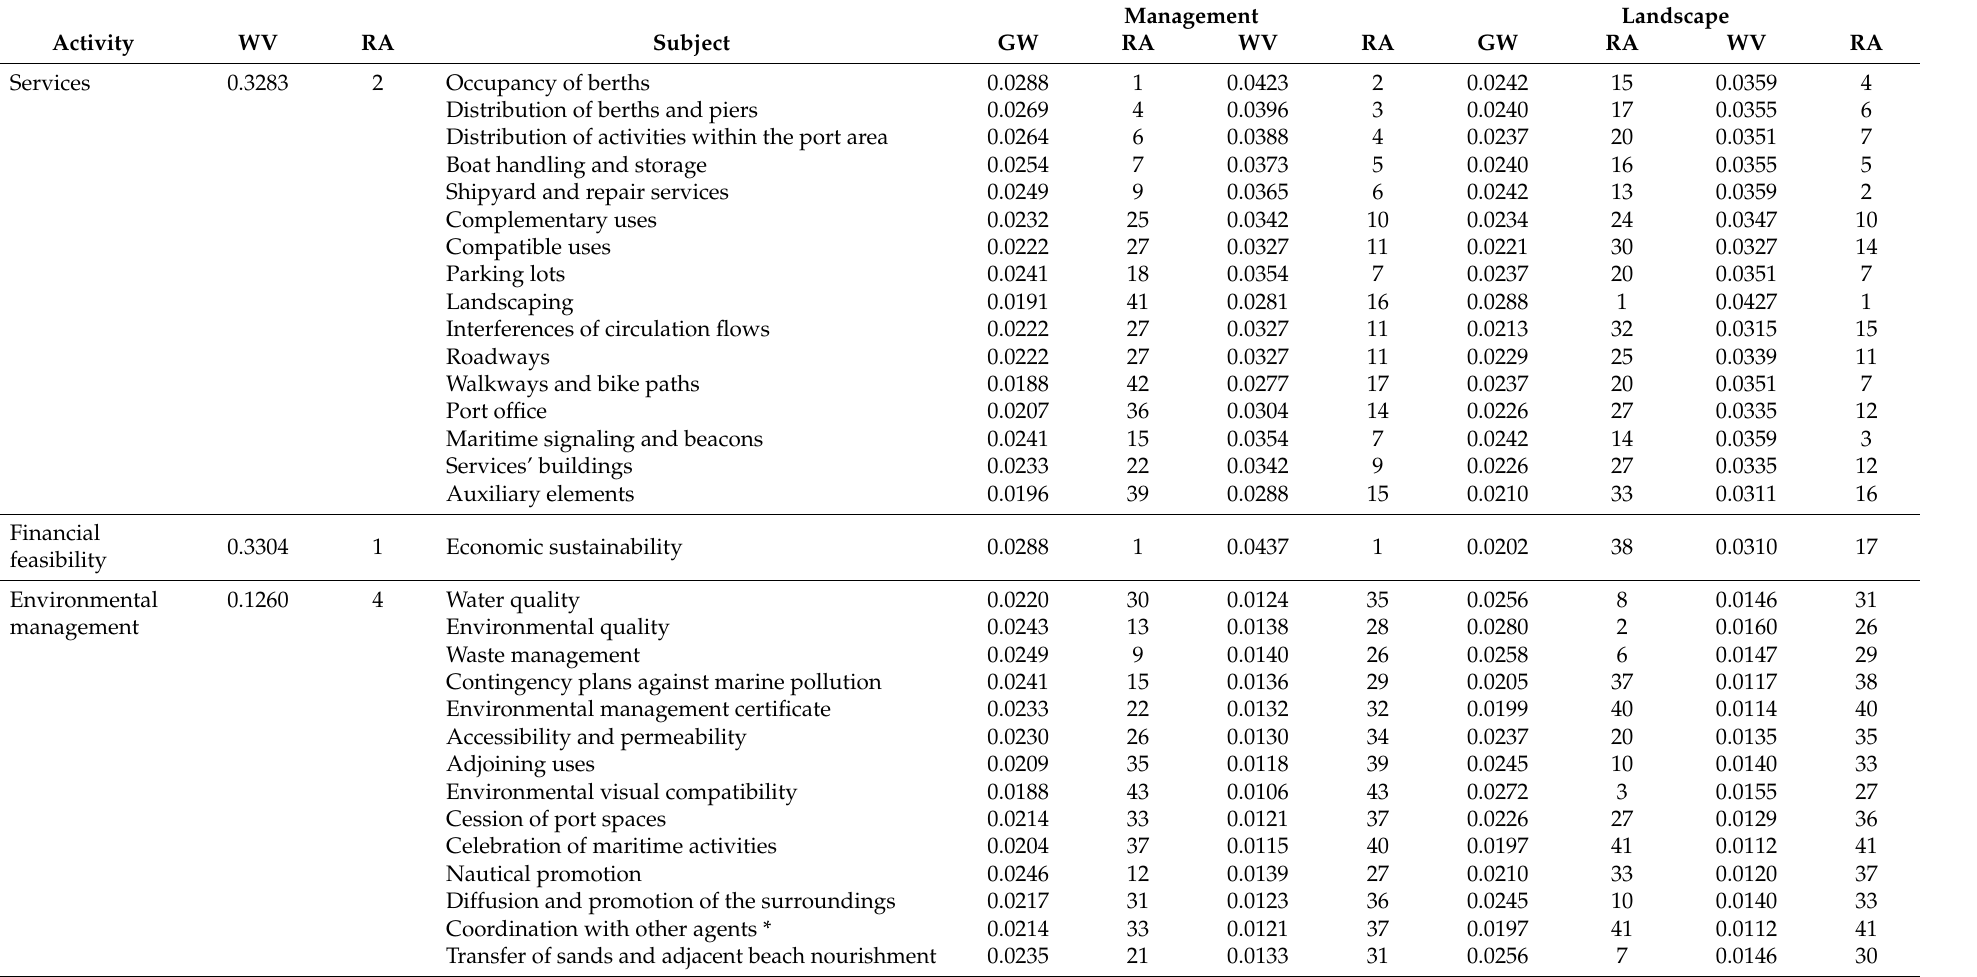
Table 1. Ranking framework of management and landscape in